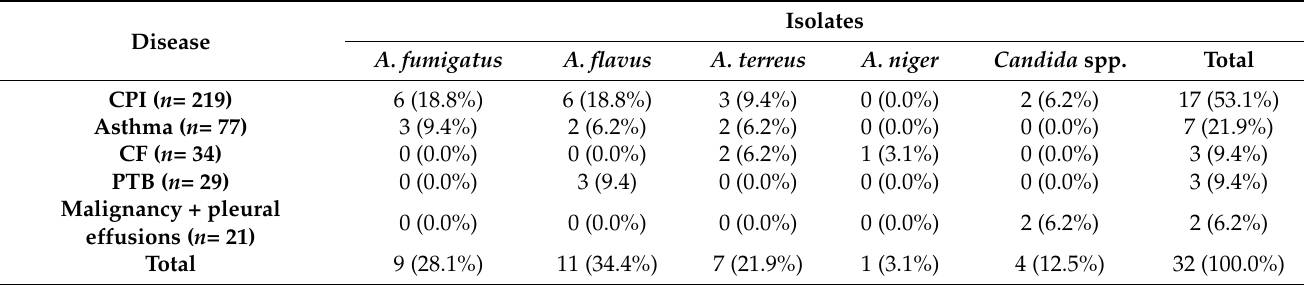
Table 3. Correlation between the underlying diseases and isolated organisms.